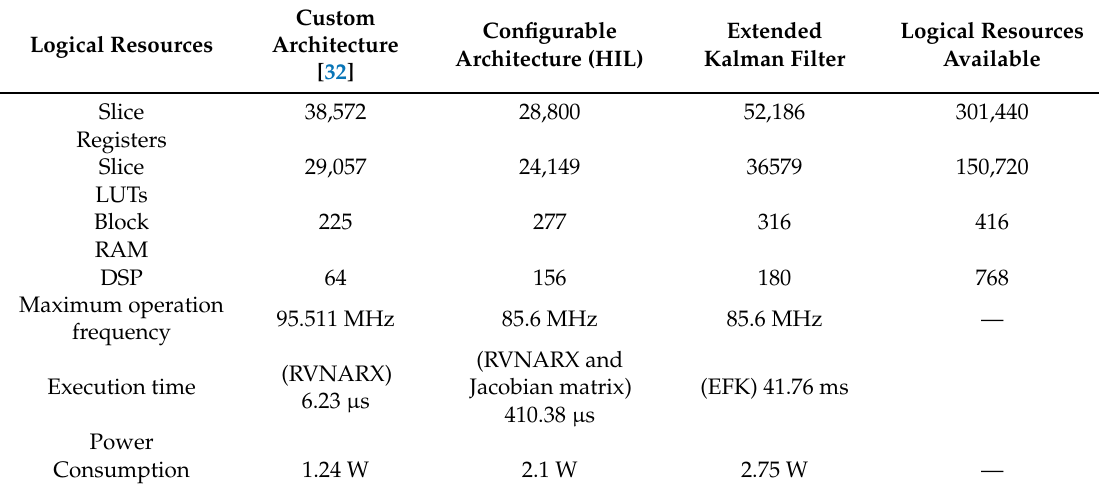
Table 1. Utilization of Logical